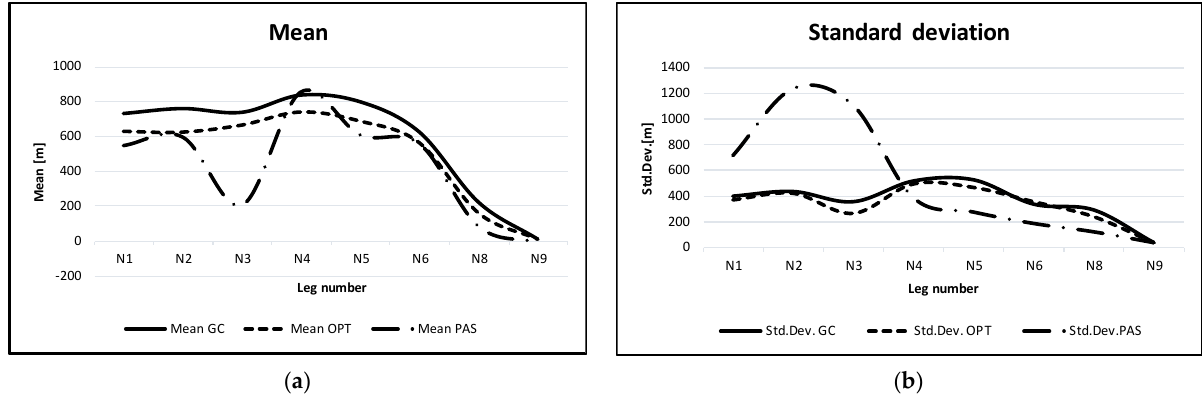
Figure 5. ( a ) The mean and ( b ) standard deviations of ship position for consecutive legs N1 to N9.